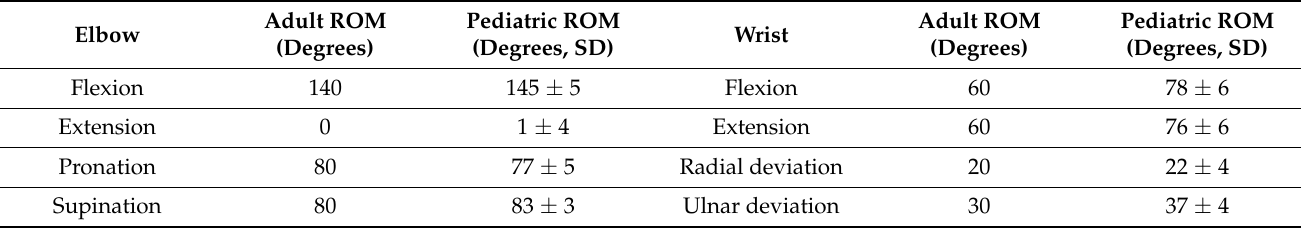
Table 1. Normal range of motion (ROM) of the elbow and wrist in degrees for both adults [4] and children